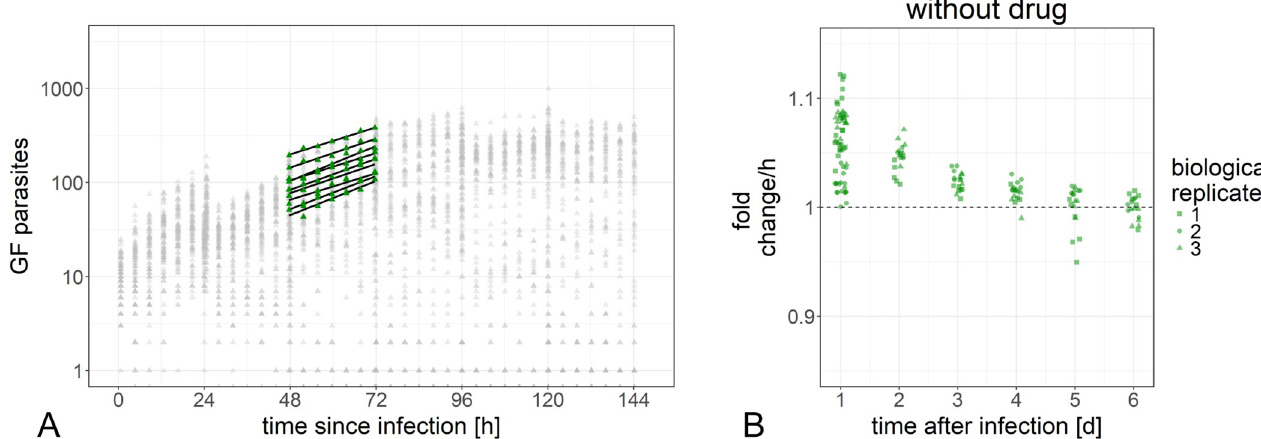
Fig 5. Exponential model of the development of parasite numbers over time. Numbers of green fluorescent parasites from one plate are plotted over time after infection (A). The parasite numbers obtained at the seven time points from the 9 sites in one well from this plate are highlighted in green as an example. The exponential models (Methods) determined for every site of this well are plotted for illustration. The variable “fold change per h” of those exponential models for every site of all plates changes between days after infection (B).